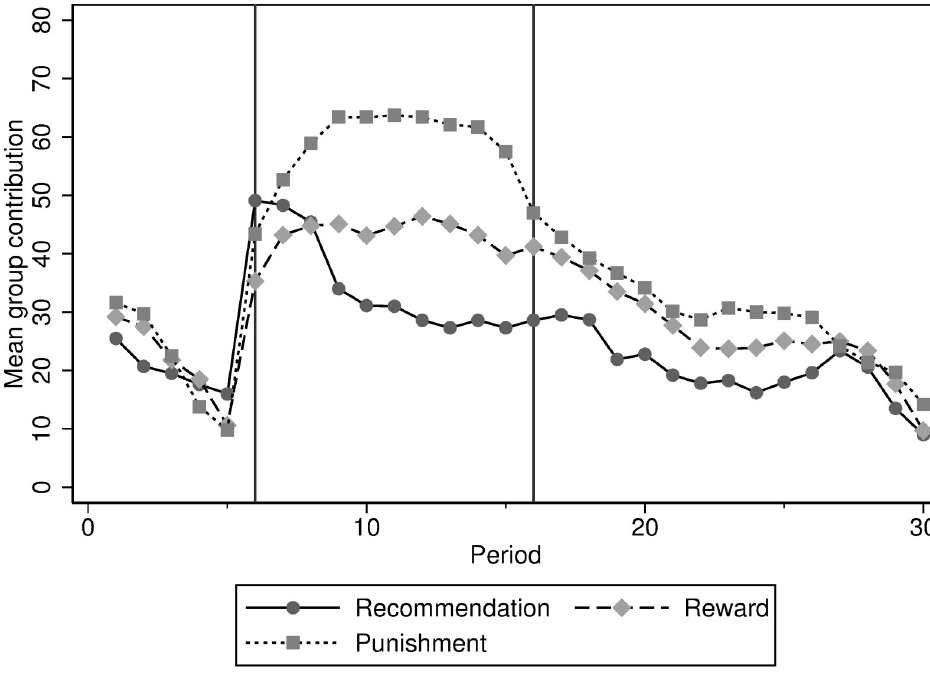
Fig 1. Average group